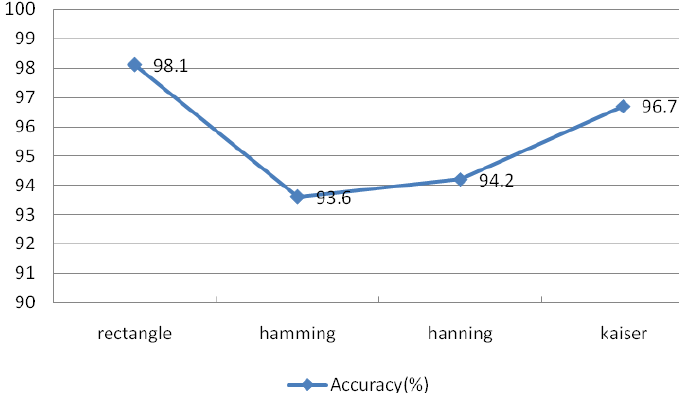
Figure 24. Comparison of different window types.